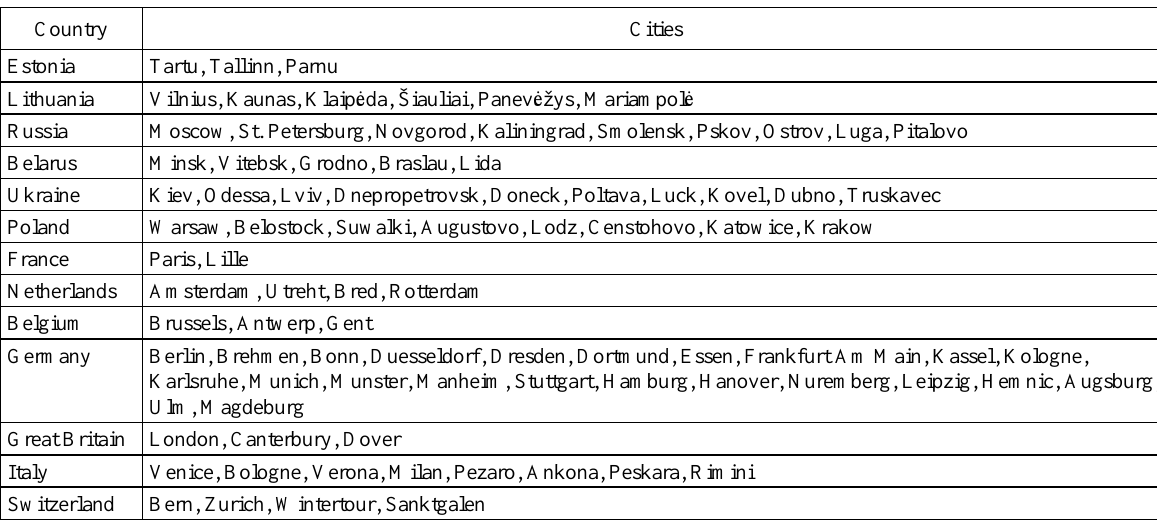
Table 2. Average number of routes per day and breakdown by directions (at the peak hours in 2006) Routes